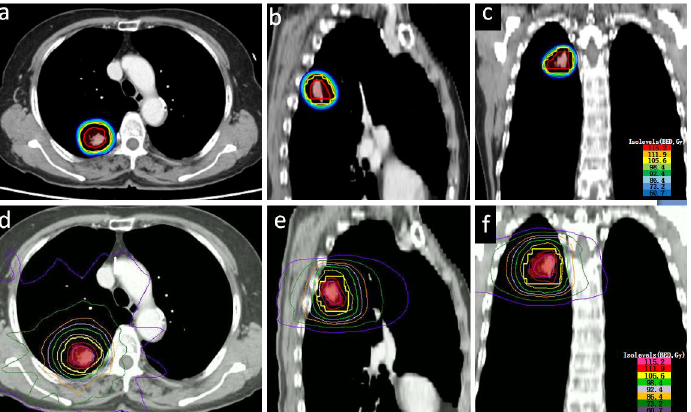
Fig 1. Representative dose distributions for the patient 5inSBT and SBRT after radiobiological conversion. a, b and c are the axial, sagittal and coronal dose distributionin SBT respectively. The red, orange, yellow, green-yellow, green, light sky blue, dodgerblue, and corn flower blue lines represent the 115.2Gy(BED), 111.9Gy(BED), 105.6Gy(BED), 98.4Gy(BED), 92.4Gy(BED), 86.4Gy(BED), 73.2Gy(BED), and 60.7Gy(BED) isodosecurves respectively.d, e and fare the axial, sagittal, and coronal dose distributions in SBRT, respectively.The hot pink, crimson, yellow, green-yellow, plum, orange, leaf green, and dark violet lines represent the 126Gy(BED), 118Gy(BED), 101Gy(BED), 92Gy(BED), 81Gy(BED), 70Gy(BED), 46Gy (BED) and 23Gy(BED) isodose curves respectively.